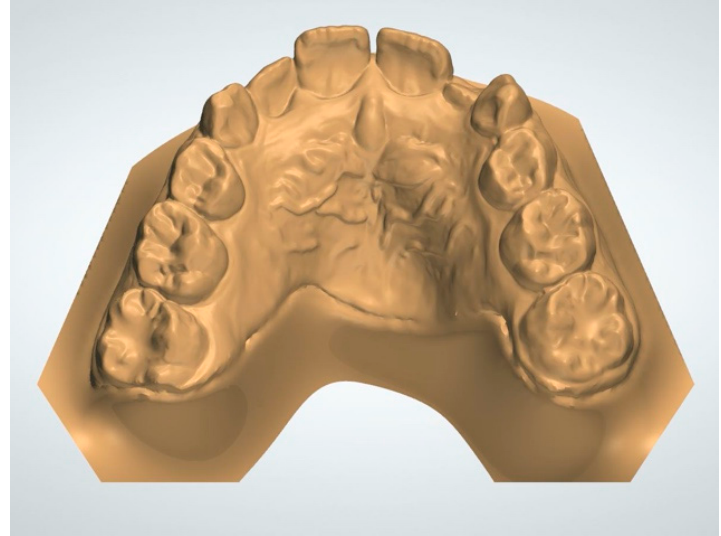
Figure 2. Dental model acquired through intra-oral